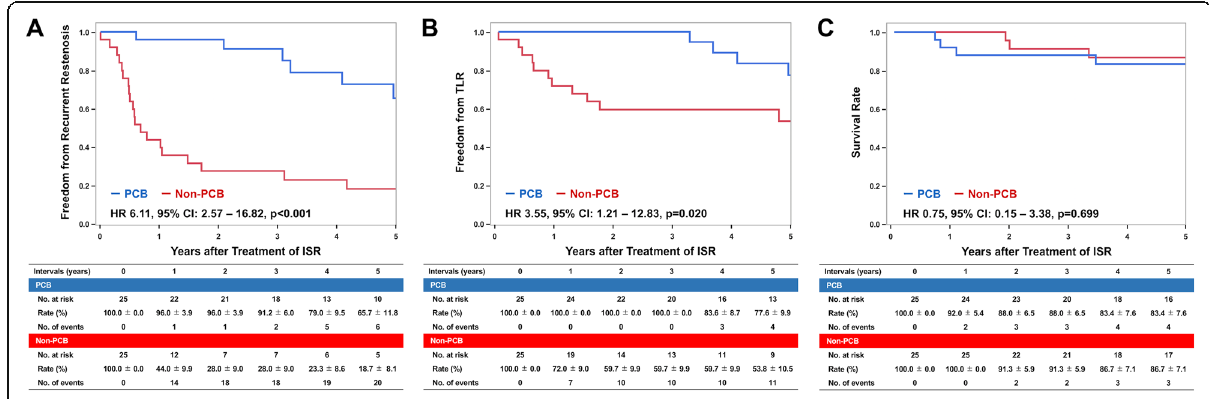
Fig. 2 Clinical Events After EVT within 5 Years. a freedom from recurrent restenosis, b freedom from TLR, and c survival rate. CI indicates confidence intervals; HR, hazard ratio; ISR, in-stent restenosis; PCB, paclitaxel-coated balloon; TLR, target lesion revascularization